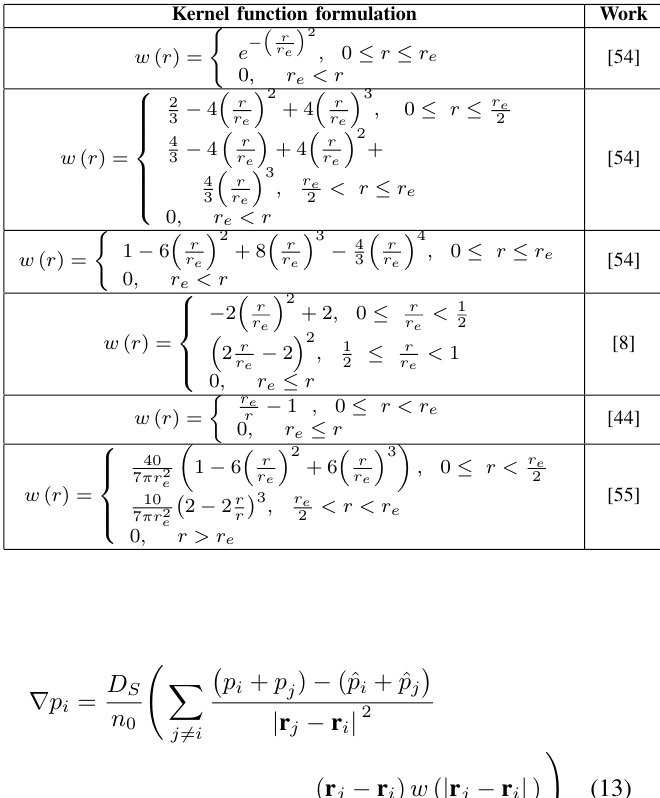
TABLE I: Different kernel functions Kernel function formulation